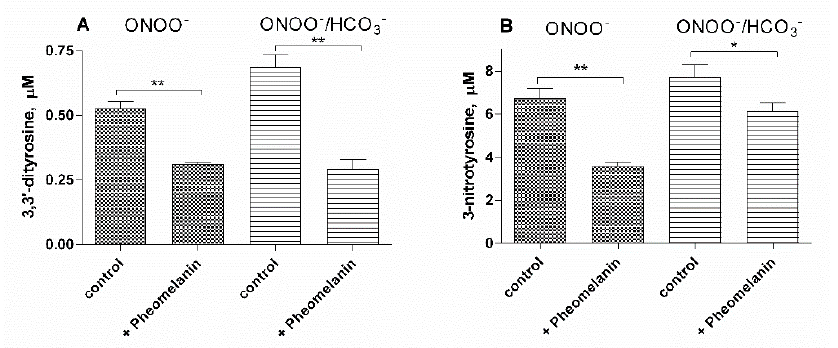
Figure 8. Pheomelanin effect on peroxynitrite-induced oxidation/nitration of tyrosine. To the reaction mix containing 100 µ M tyrosine, 4.2 µ g/mL pheomelanin, 0.1 mM DTPA in 0.2 M K-phosphate buffer, 100 µ M peroxynitrite is added, Na-bicarbonate when present is at a concentration of 25 mM. After 5 min at room temperature, the reaction mixture is analyzed by HPLC to measure 3,3’-dityrosine ( A ) and 3-nitrotyrosine ( B ), as reported in Materials and Methods. ** p < 0.01, * p < 0.05 .